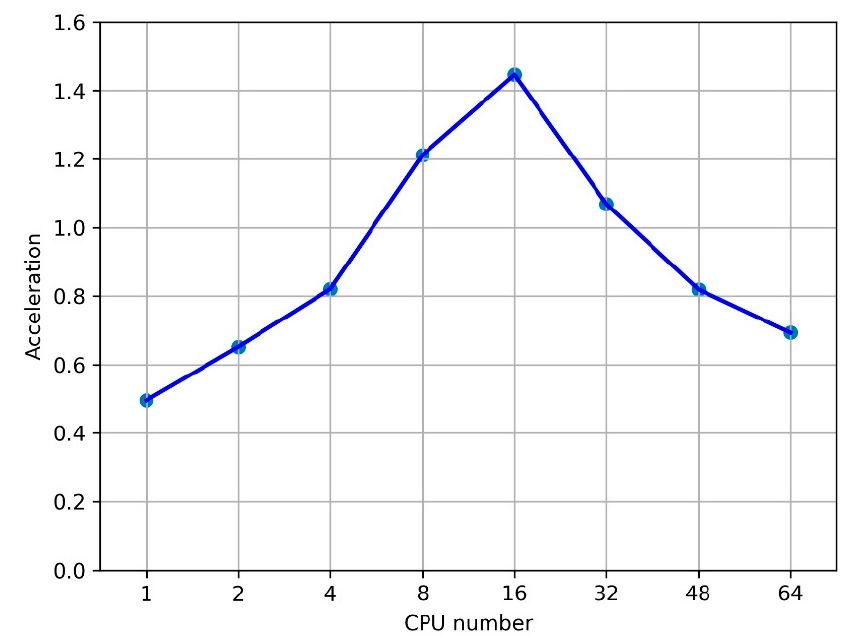
Figure 8. Dependence of acceleration on the program of the second block.